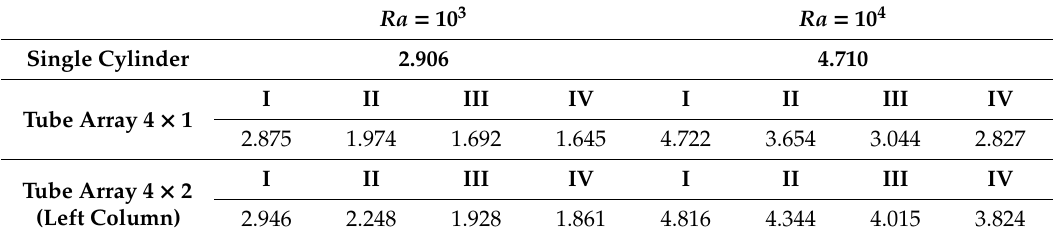
Table 3. Average Nusselt numbers Nu av for the single cylinder and tube arrays 4 × 1, 4 × 2 at Ra = 10 3 and Ra = 10 4